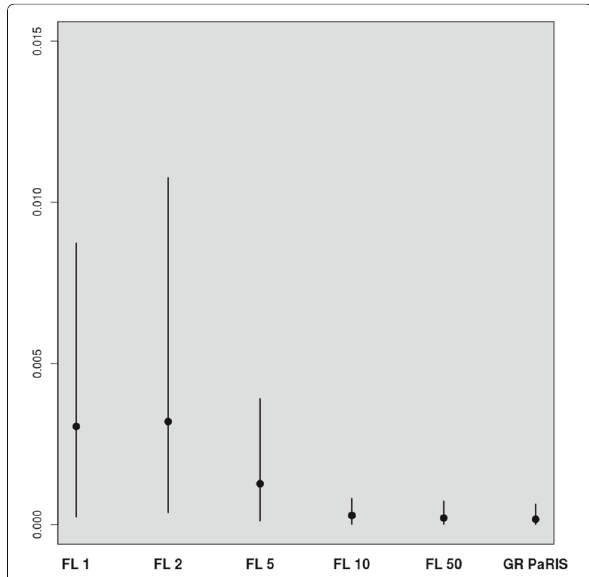
Fig. 4 SINE model - bias. Distribution of the empirical absolute relative bias